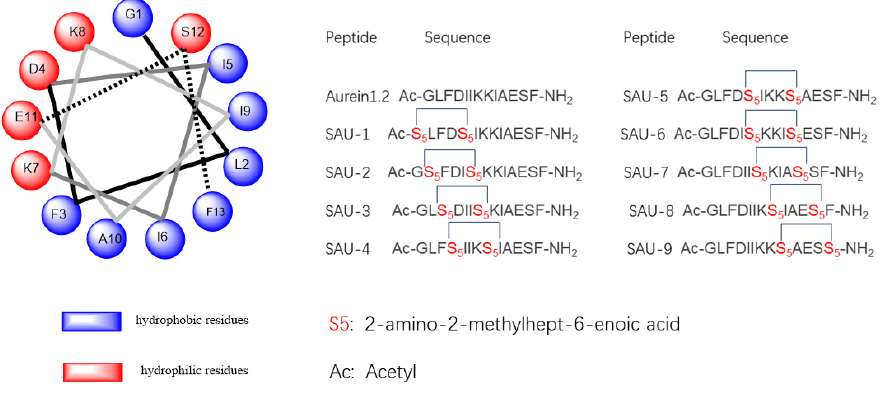
Figure 1. The sequences of Aurein1.2 and the stapled Aurein1,2 peptides.